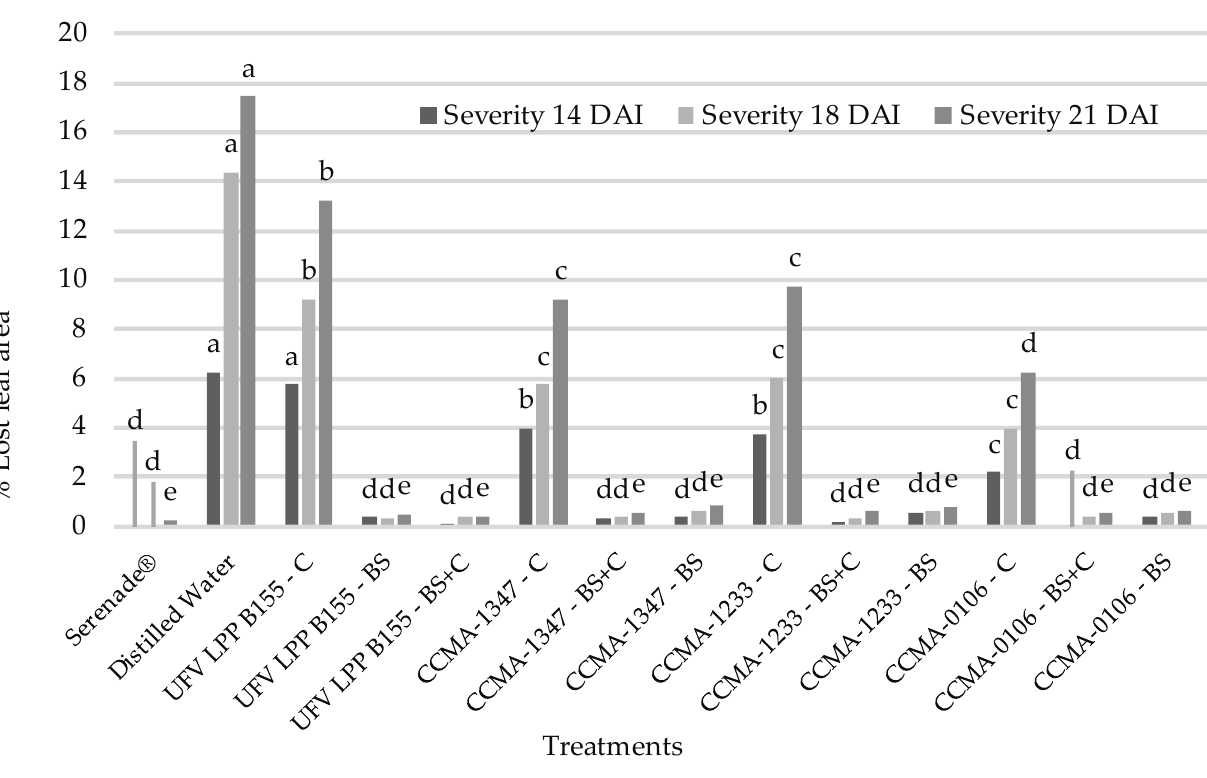
Figure 3. Asian soybean rust severity graph after 14, 18 and 21 days of pathogen inoculation (14 DAI, 18 DAI, 21 DAI). UFV LPP B155 and CCMA-1347 = B. subtilis ; CCMA-1233 = B. licheniformis ; CCMA-0106 = P. aeruginosa . BS : Biosurfactants; C : Bacterial cells; BS + C : Biosurfactants + Bacterial cells. Severity is based on leaf area lost to lesions. For the same day of observations, bars followed by the same letter do not differ from each other in the Tukey test α = 0.05. Different letters reveal statistically significant variations ( p <